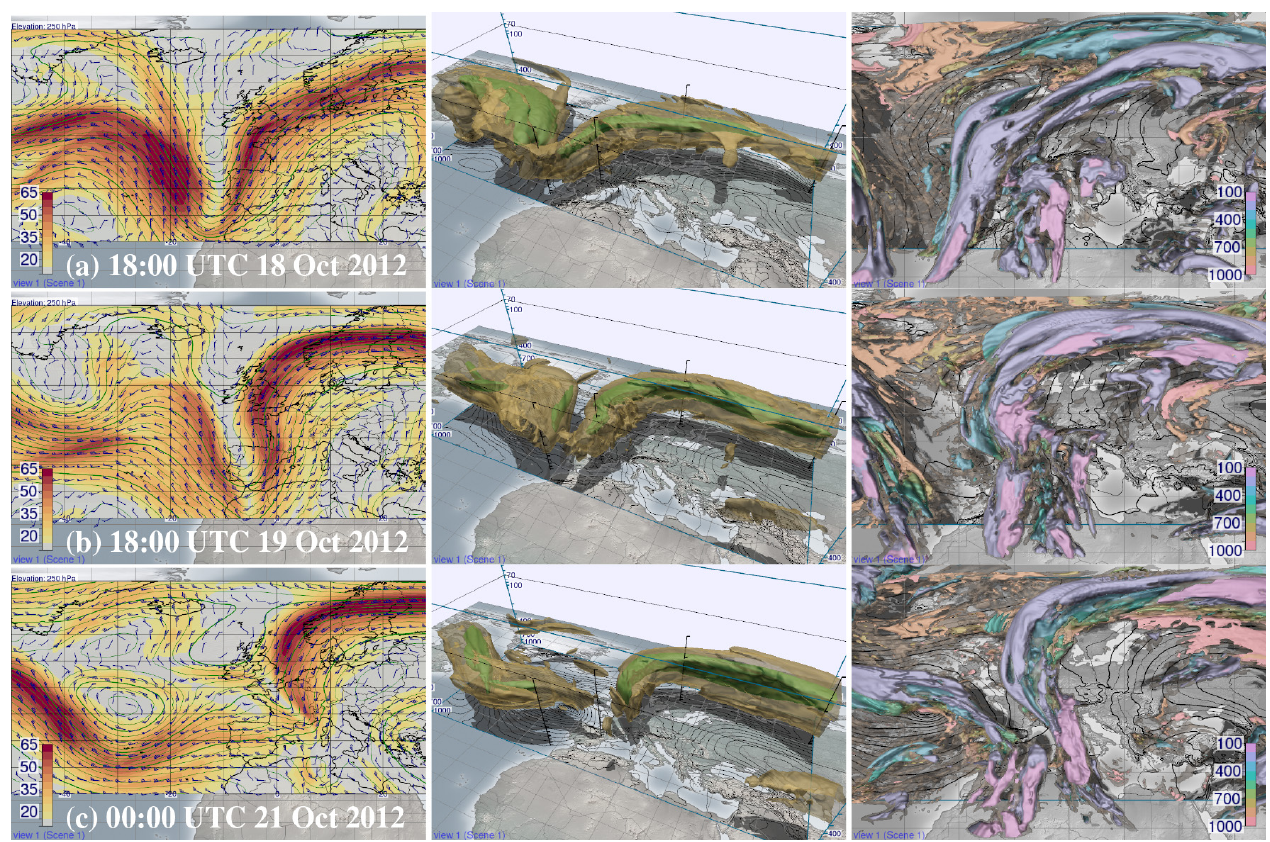
Figure 10. Time sequence of (left) horizontal section with contour lines of geopotential height and filled contours of wind speed (ms − 1 ) at 250hPa, (middle) jet stream (opaque isosurface 50ms − 1 , transparent isosurface 30ms − 1 , and black contour lines of sea level pressure) and (right) clouds (opaque isosurface cloud cover fraction of 0.7, transparent isosurface cloud cover fraction of 0.2, and black contour lines of sea level pressure). Colour coding in the right panel denotes cloud elevation in hPa. Deterministic forecast from 00:00UTC, 15 October 2012, valid at (a) 18:00UTC, 18 October 2012, (b) 18:00UTC, 19 October 2012 and (c) 00:00UTC, 21 October